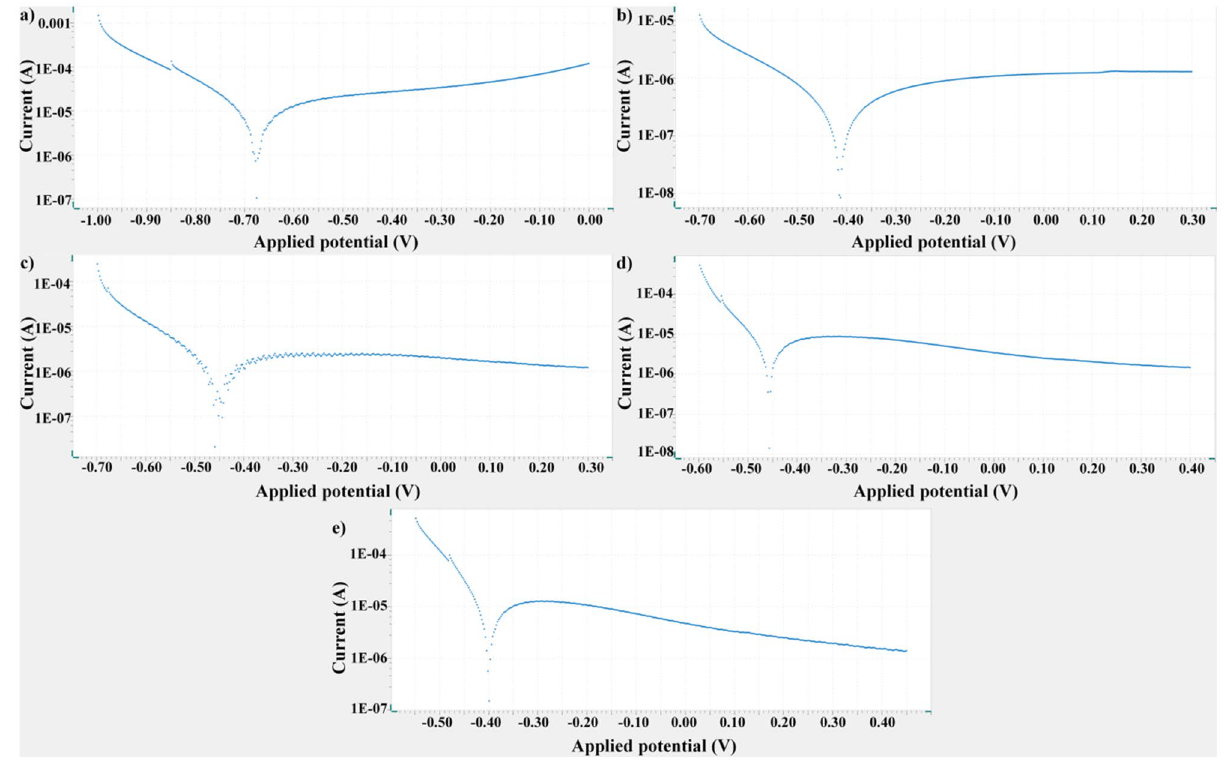
Figure 5. Tafel polarization curves of bare Gr2, bare nanotube and AgNPs-deposited nanotube